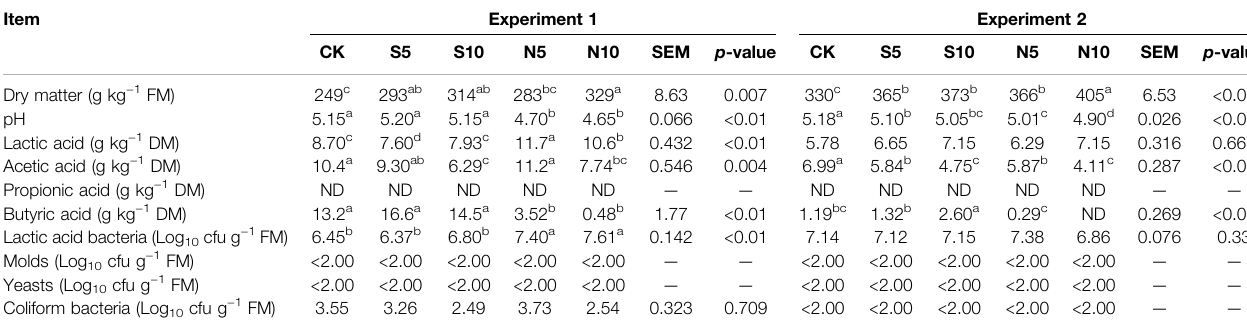
TABLE 2 | Fermentation characteristics and microbial populations of stylo silage ( n = 3). Item